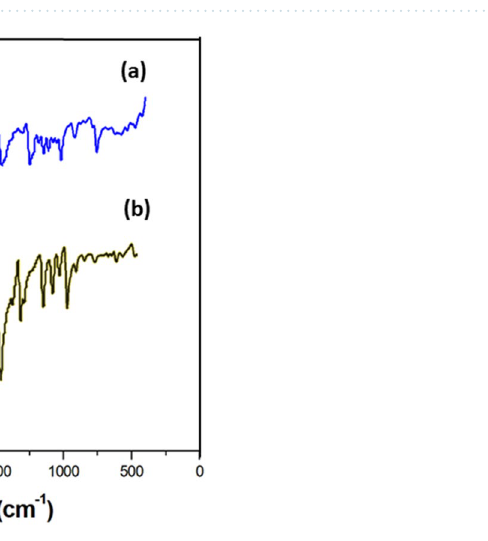
Figure 7. Infrared absorption spectra of ( a ) {[Co(SCN) 4 ] (C 8 H 12 N) 3 }·Cl and ( b ) {[Co(SCN) 4 ] (C 5 H 11 N 3 ) 3